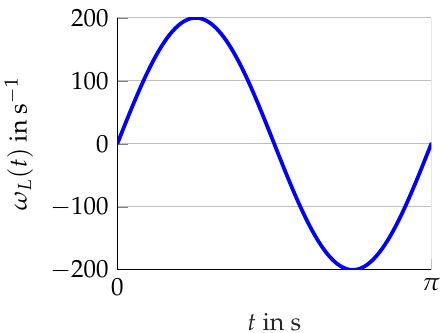
Figure 7. Scenario C for more rapid changes of ω L ( t ) (revolutions per